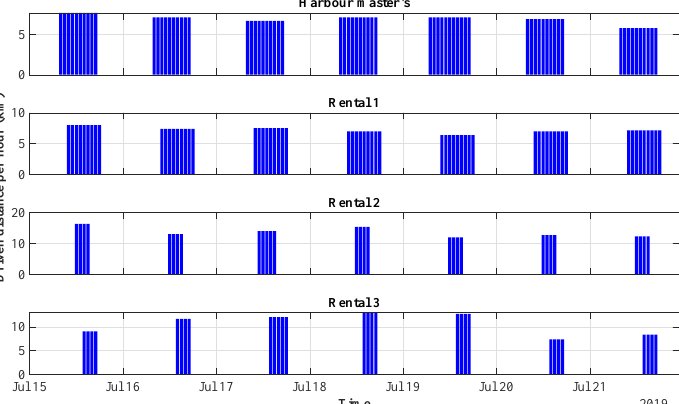
Figure 3. Generated electric car usage